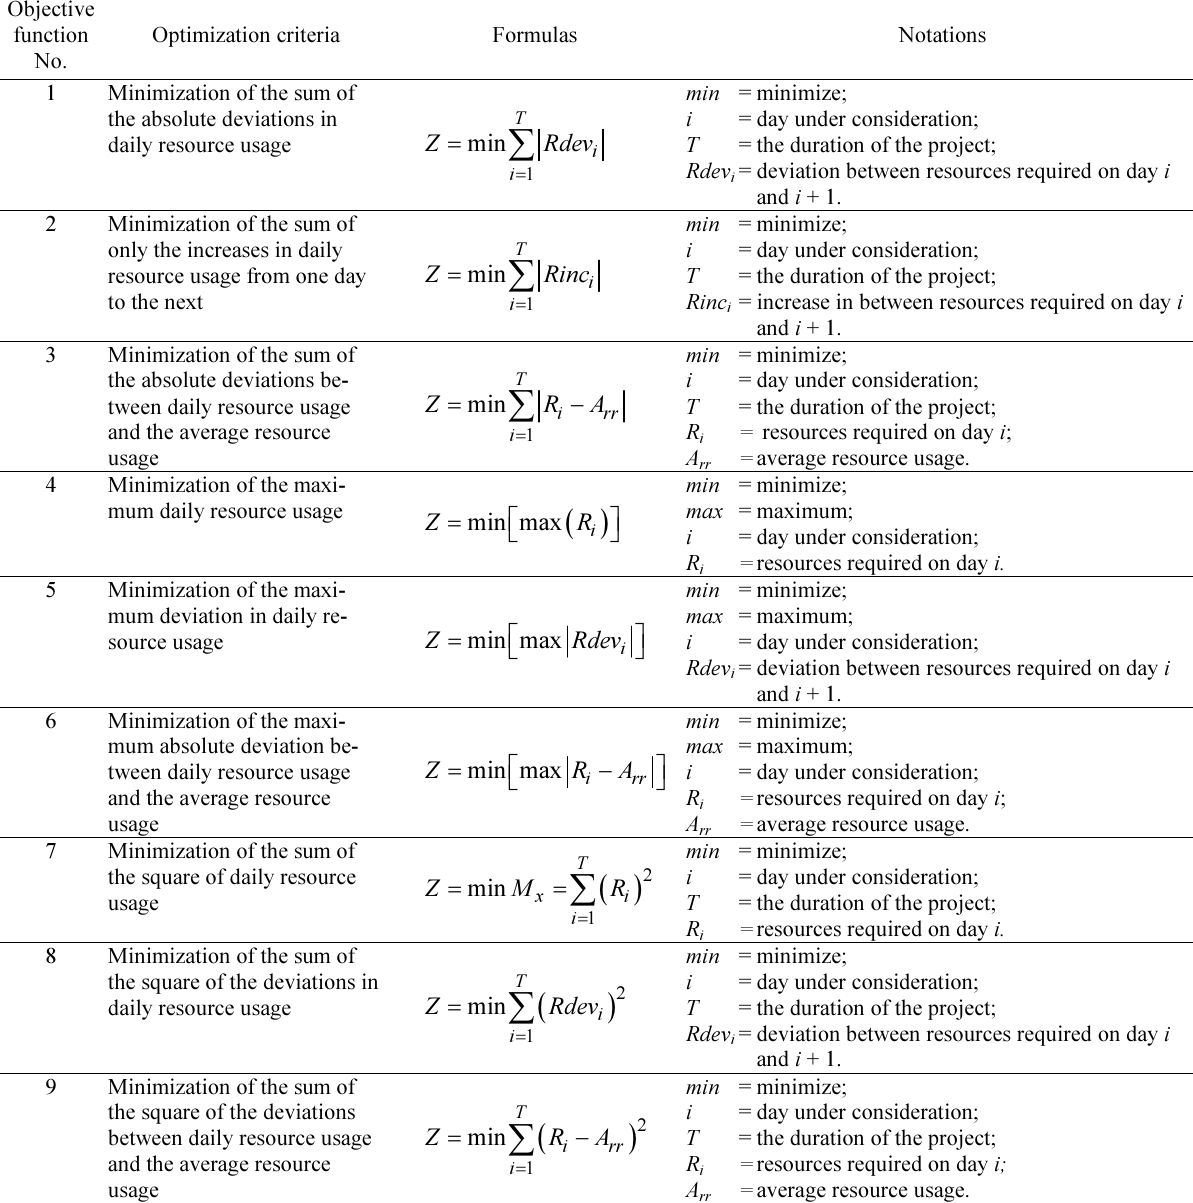
Table 2. Objective functions for resource leveling